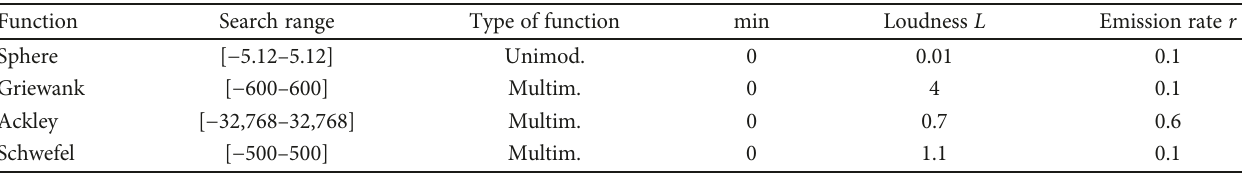
Figure 2: The responses of the algorithm with eigenvalues from Figure 1 to initial conditions. Table 1: Benchmark functions used for calculating the quality function J and analysing the e ffi ciency of BA with speci fi ed parameters (the loudness L and emission rate r ) used during experiments.